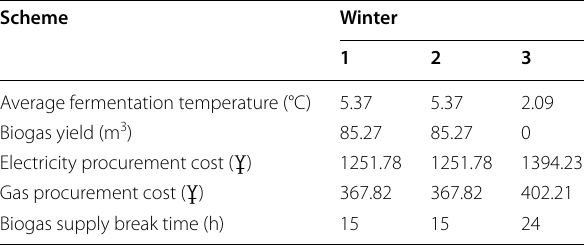
Table 3 Comparative results of schemes 1–3 on typical winter